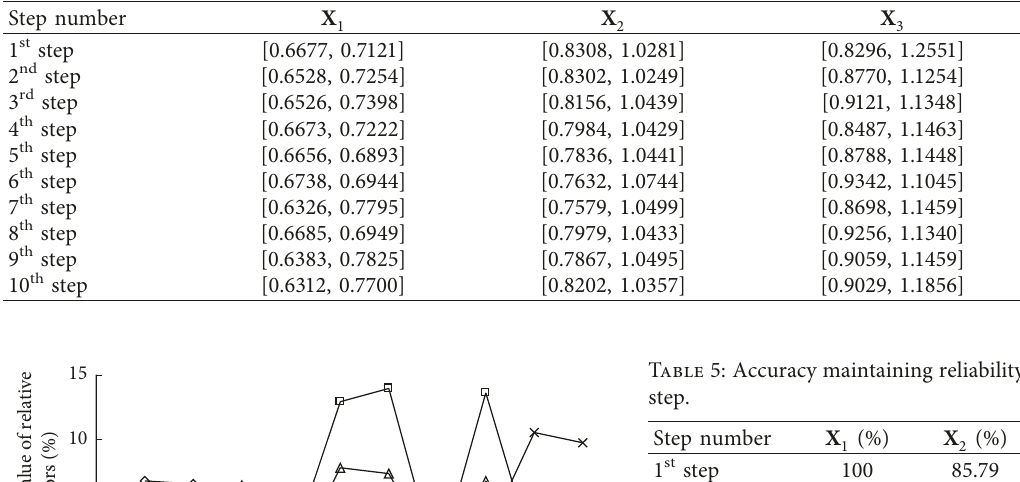
Table 3: Estimated interval [ X L , X U ] for each subseries for 10 steps in the future.